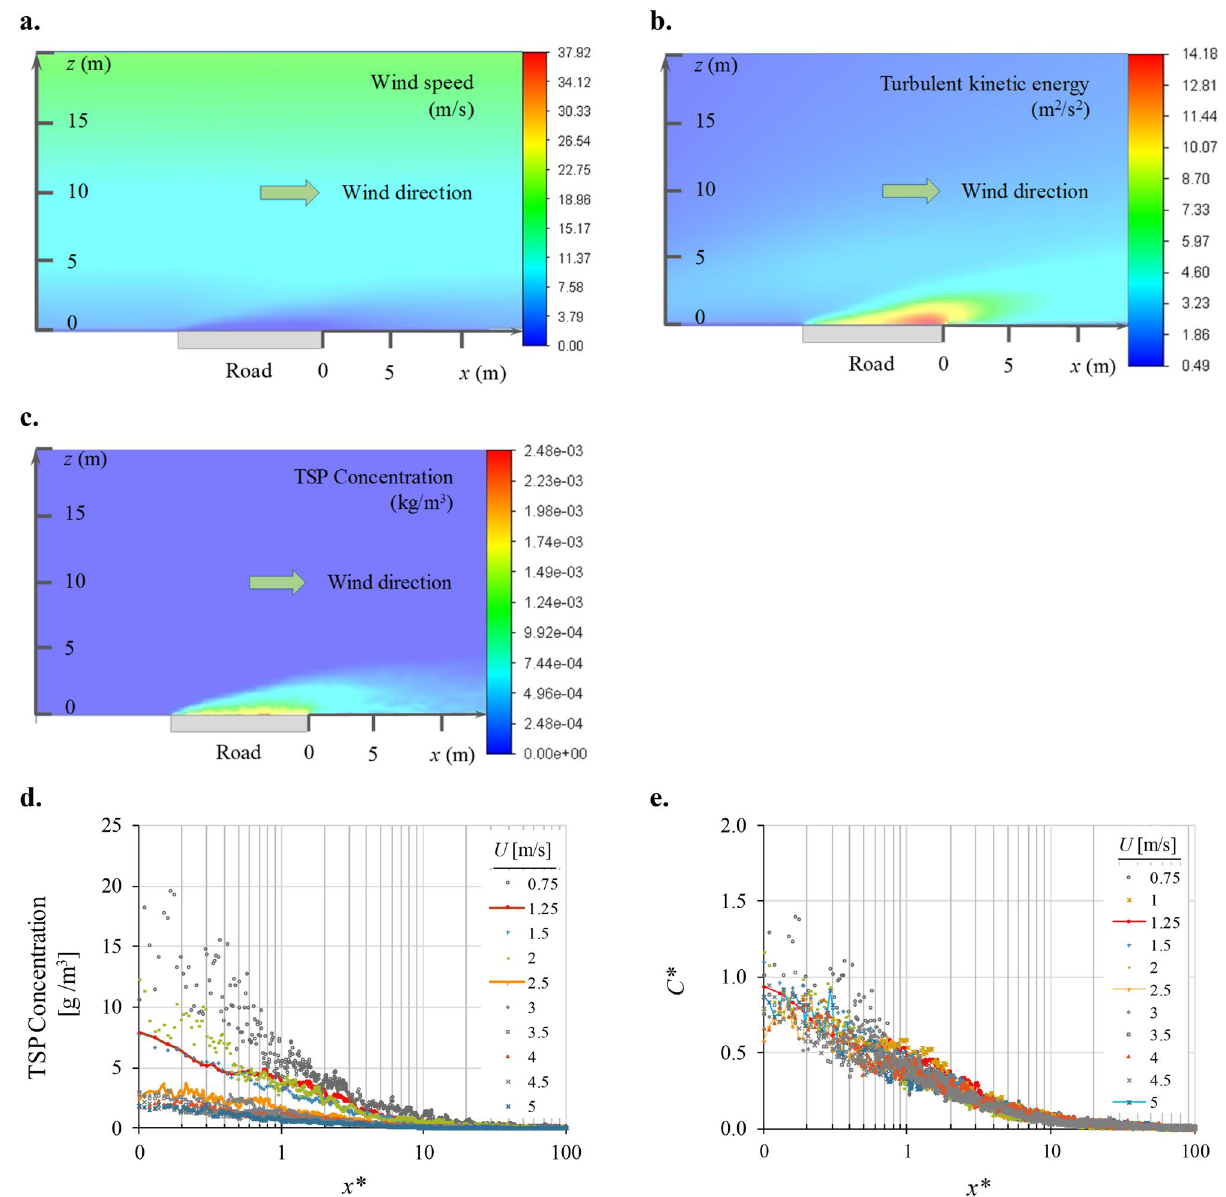
Figure 3. Results obtained by the NR-CFD model simulating the dispersion of TSP (1 < d < 34 µ m) emitted from a road located on a flat terrain without obstacles to the wind flow, under neutral atmospheric conditions. Resulting fields of ( a ) wind speed, ( b ) turbulent kinetic energy, and ( c ) TSP concentration. Resulting downwind ground TSP concentration as a function of wind speed when it is expressed as ( d ) C versus x * and ( e ) C * versus x